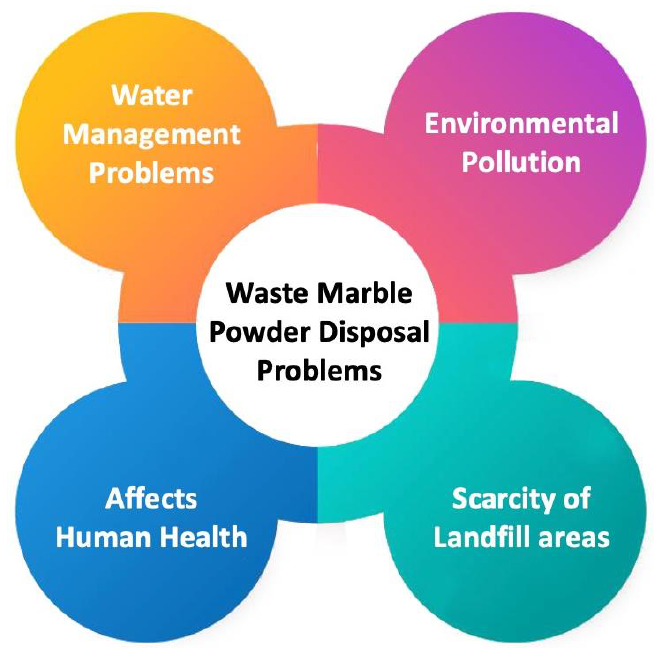
Figure 23. Marble powder disposal problems.